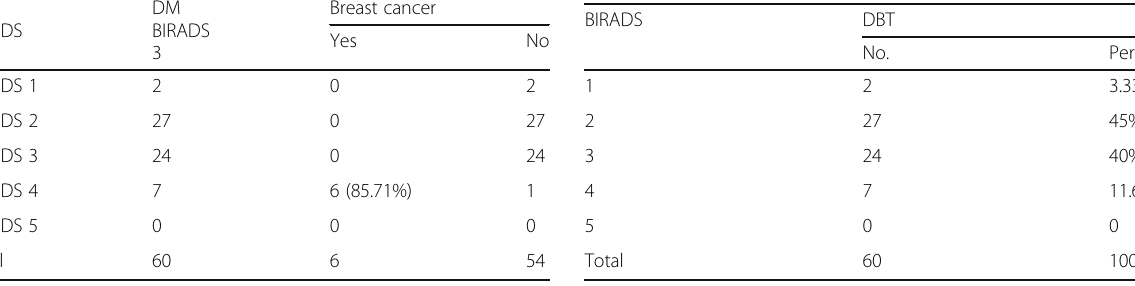
Table 6 BIRADS classification by DBT percentage change